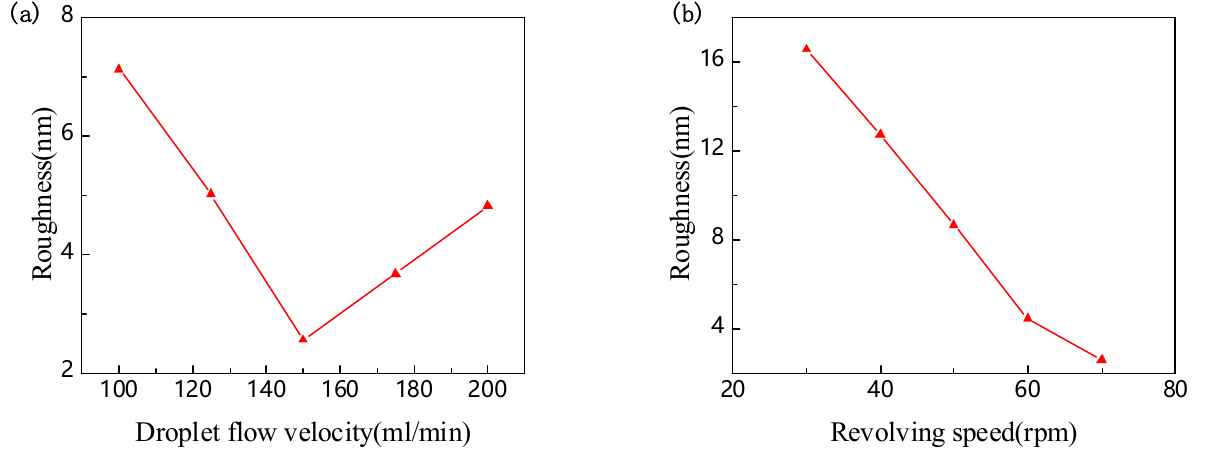
Figure 6. Roughness varied with ( a ) droplet flow velocity and ( b ) revolving speed.